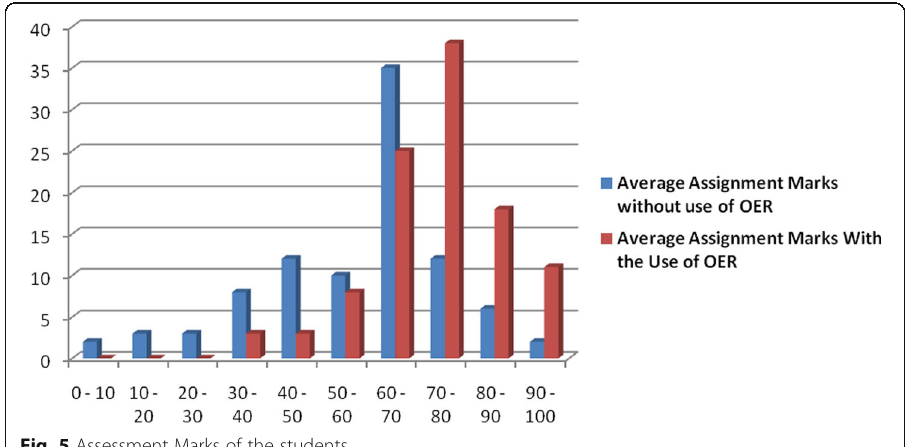
Fig. 5 Assessment Marks of the